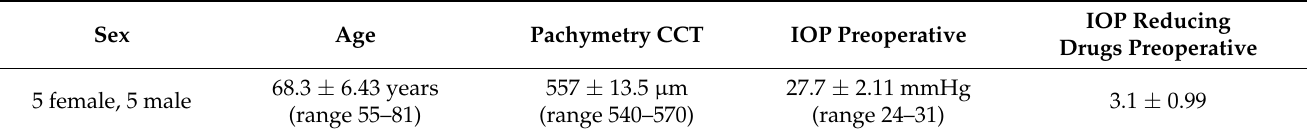
Table 1. Preoperative baseline